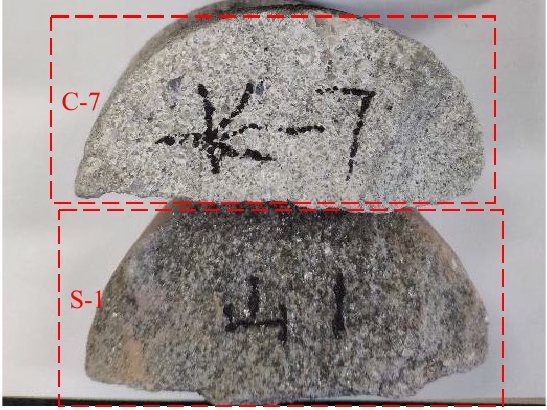
Figure 1. Downhole samples from C7 and S1 formation.